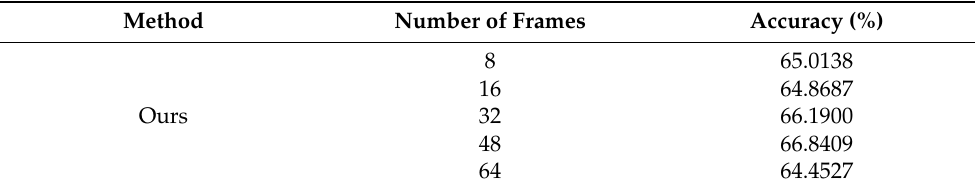
Table 9. Effect on the performance of the number of